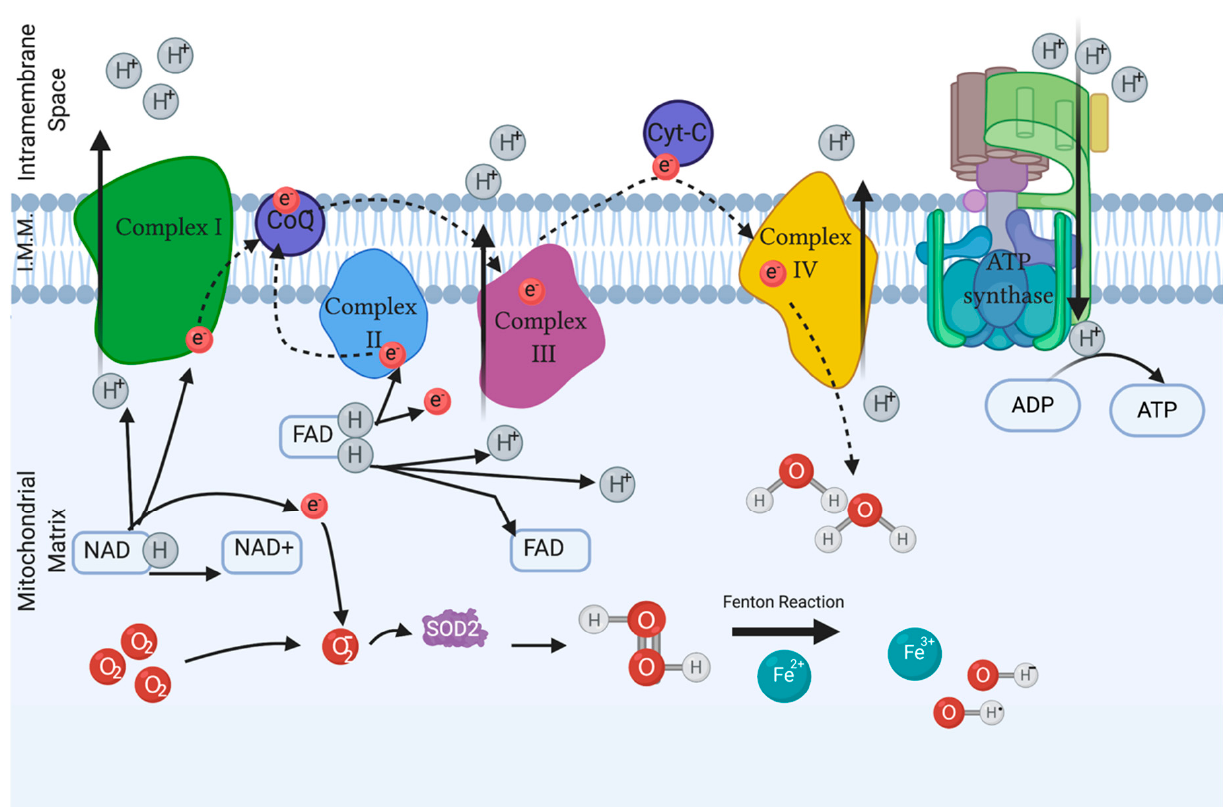
Figure 1. Flowchart of the generation of reactive oxygen species (ROS) during cellular respiration driven by the electron transport chain (ETC) in the mitochondria. Complex I, II, III, and IV constitute the ETC, and ATP synthase completes the oxidative phosphorylation. Fenton reaction constitutes the donation of an electron to transform H 2 O 2 to two molecules of hydroxyl radicals. Abbreviations: ADP: Adenosine diphosphate. ATP: Adenosine triphosphate. CoQ: Coenzyme Q, ubiquinone. Cyt-C: cytochrome complex. FAD: FADH 2 reduced form. FADH 2 : Flavin adenine dinucleotide. Fe 2+ : Ferrous ion. Fe 3+ : Ferric ion. H: Hydrogen. I.M.M.: Internal mitochondrial membrane. NAD: NADH reduced form. NADH: Nicotinamide adenine dinucleotide. O 2 : Oxygen. O 2 − : superoxide. SOD2: Superoxide dismutase 2 (mitochondrial variety).